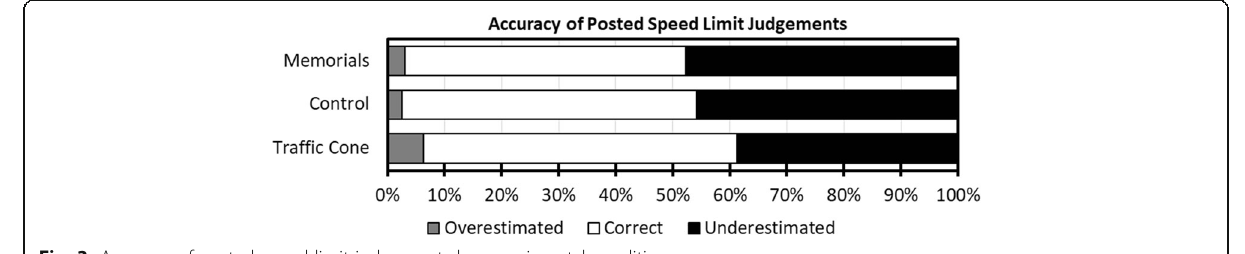
Fig. 3 Accuracy of posted speed limit judgements by experimental